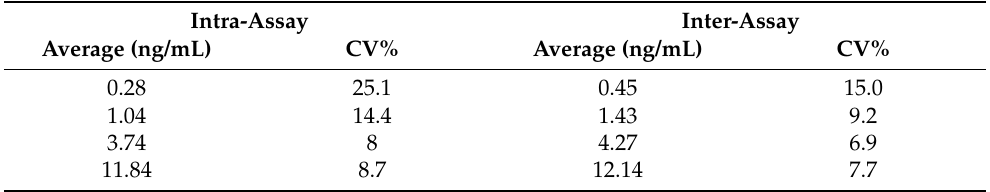
Table 2. Accuracy of immunoassay developed for glyphosate determination in surface water, soil, and plant tissues.